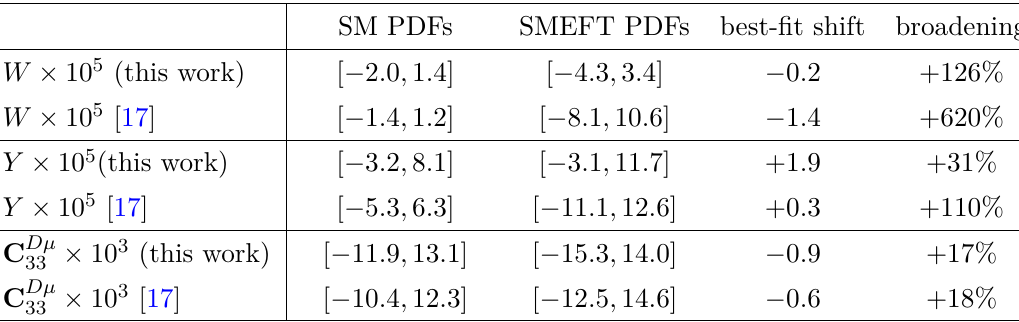
Table 4 . 95% C.L. bounds on the simultaneous fit of the W and Y Wilson coefficients in Benchmark Scenario I and of the individual fit of the C Dµ Wilson Coefficient in Benchmark Scenario II, based 33 on a fit inclusing the HL-LHC projections, compared to those obtained in the previous analysis presented in ref. [17]. The fourth and fifth column indicate the absolute shift in best-fit values, eq. (4.3) and the percentage broadening of the SMEFT bounds, eq. (4.4), when the PDFs are allowed to change alongside the Wilson